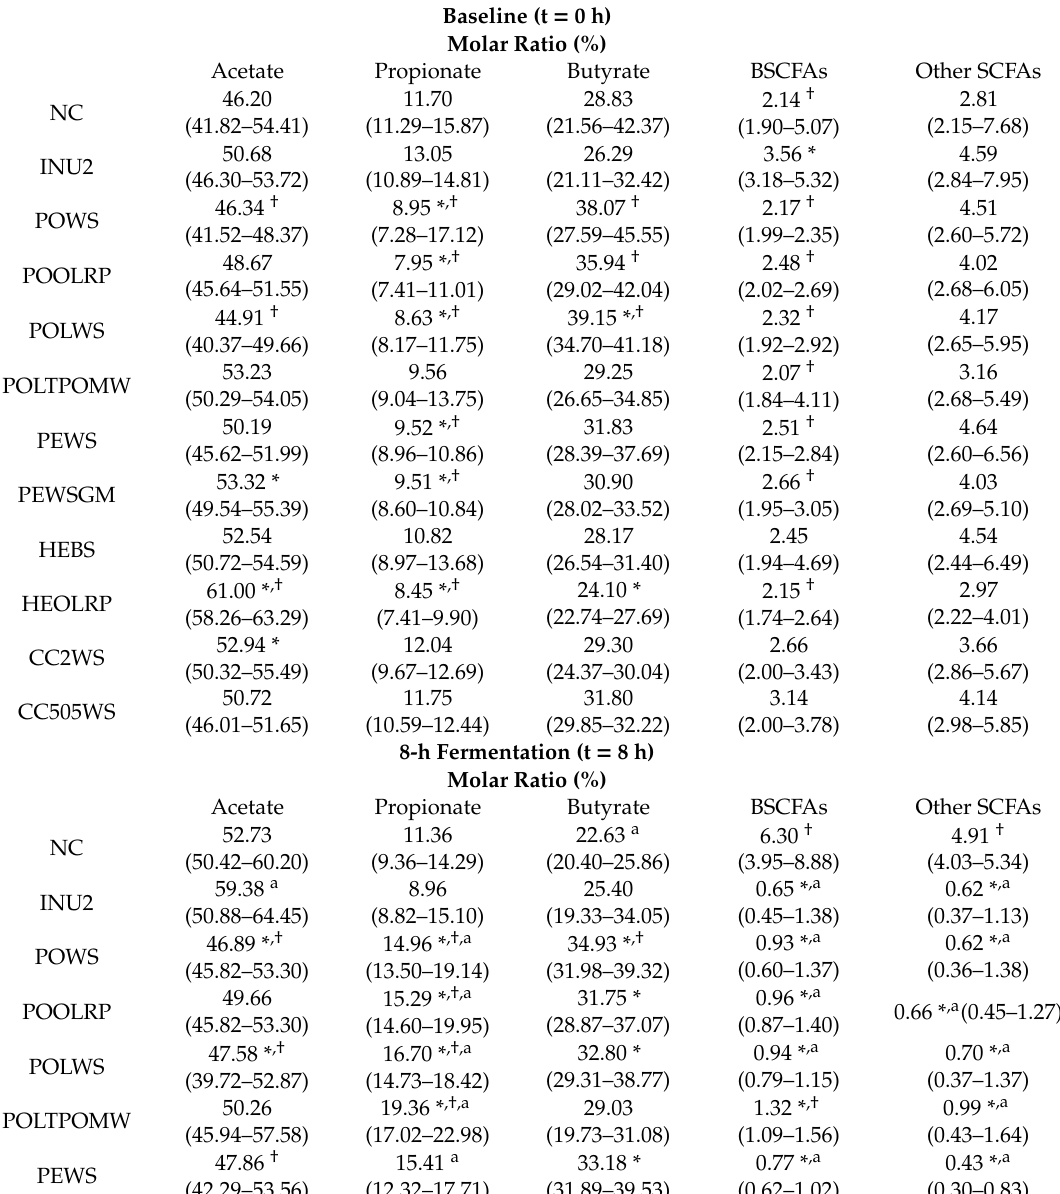
Table 5. Molar ratios (%) of SCFAs at baseline and after 8 h and 24 h